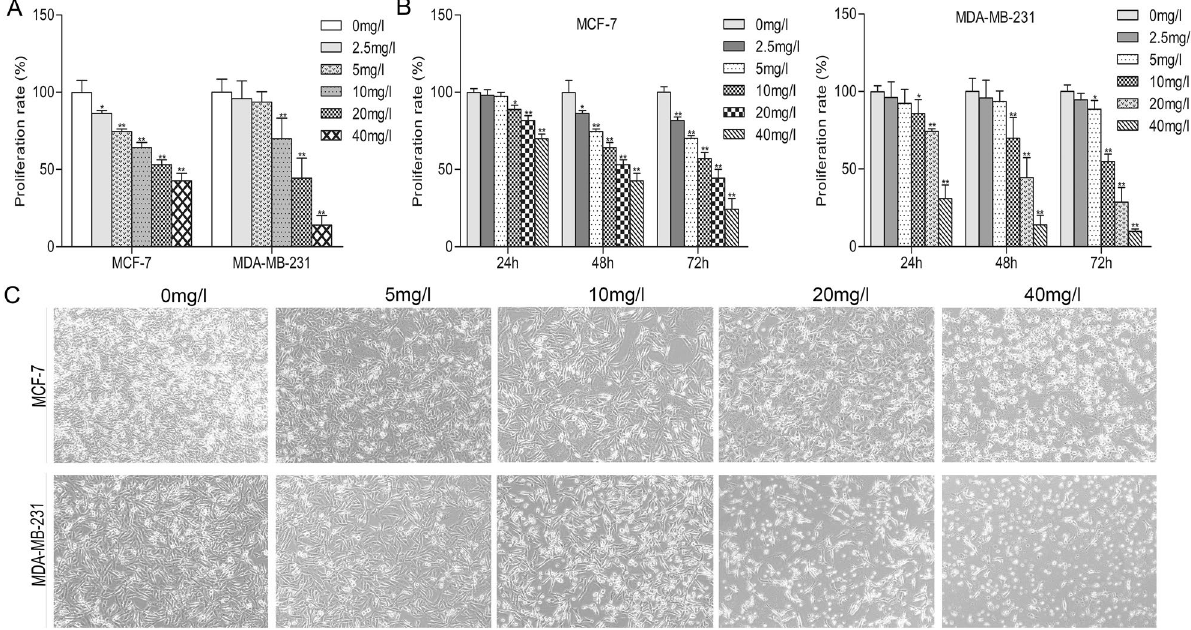
Figure 1. Effects of VALD-3 on the cytotoxicity and proliferation of breast cancer cell lines. ( A ) The effect of anti-proliferation of VALD-3 on MCF-7 and MDA-MB-231 cells was measured by MTT assay. Cells were inoculated into 96-wellplate and treated with different concentrations of VALD-3 for 48 h. ( B ) VALD-3 inhibits proliferation of MCF-7 and MDA-MB-231 cells in a concentration-dependent manner and a time- dependent manner. MCF-7 and MDA-MB-231 cells were cultured in 96-well plates and treated with different concentrations of VALD-3 for 24 h, 48 h and 72 h, respectively; the cell viability was determined by the MTT assay. Each data are presented as the mean ± SD from four independent experiments * P < 0.05, ** P < 0.01 versus control group. ( C ) Morphological assessment of control and VALD-3 treated breast cancer MCF-7 and MDA-MB-231